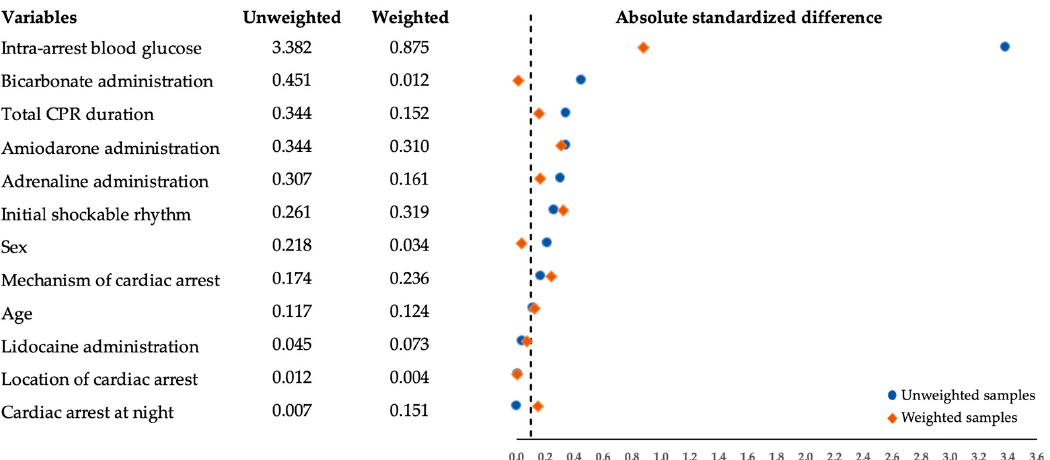
Figure 2. Balance in prognostic factors at baseline based on absolute standardized differences between the unweighted and weighted samples. CPR, cardiopulmonary resuscitation.